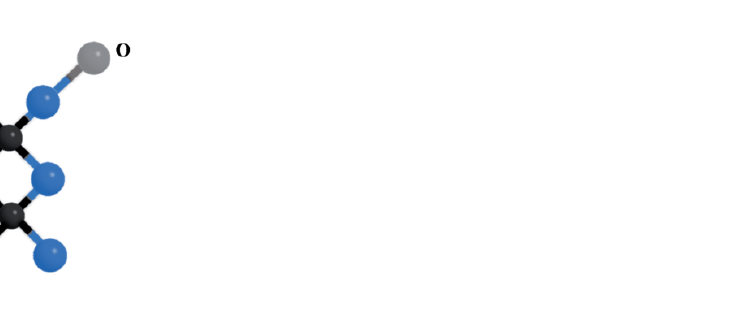
Figure 16. Schematic illustration of H 2 sensing mechanism of the Pd-decorated Ti 3 C 2 T x . Republished with permission from [91]. Royal Society of Chemistry, Creative Commons Attribution 3.0 Un- ported License.